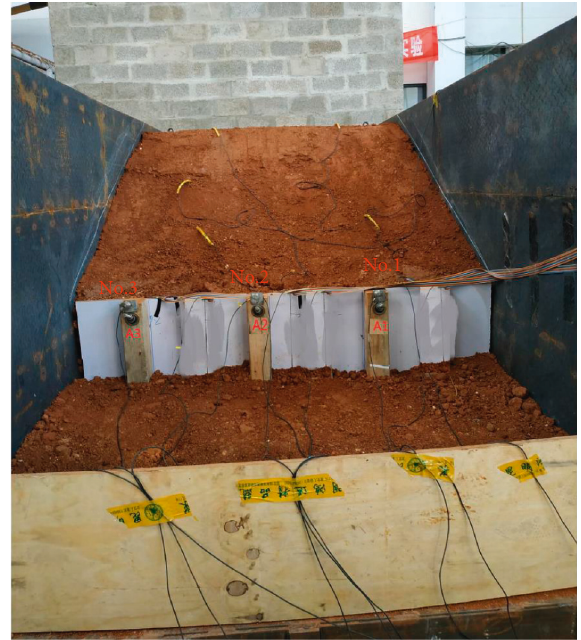
Figure 3: Acceleration